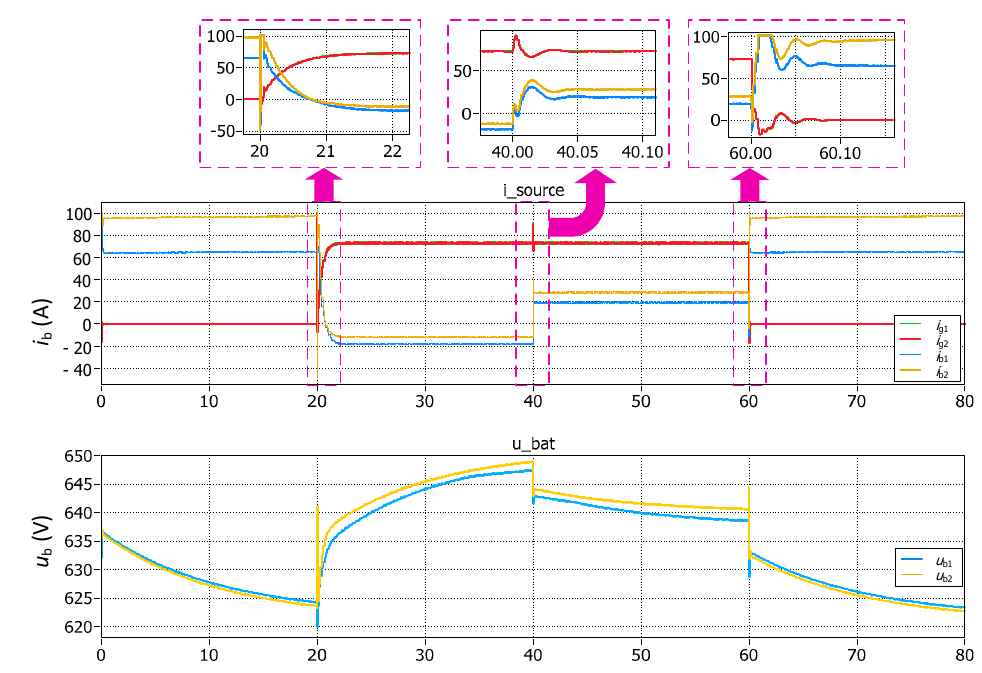
Figure 15. The DC bus voltage and load current during mode switching.